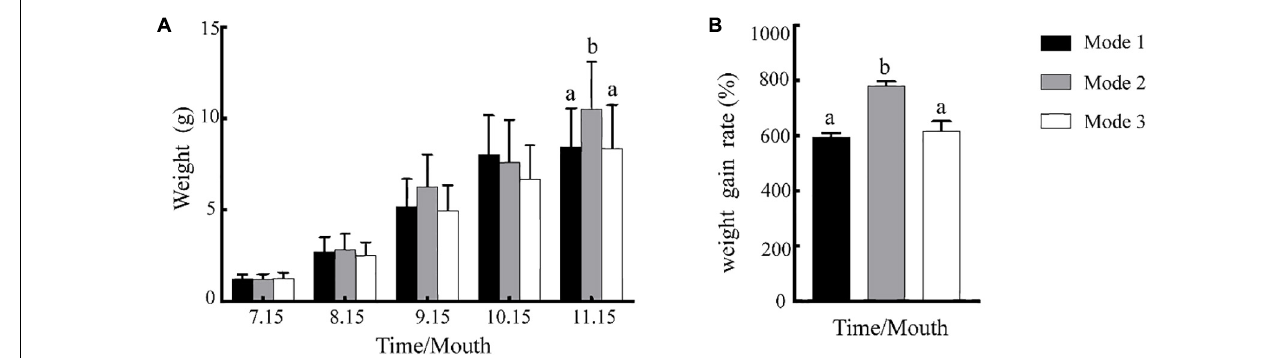
FIGURE 2 | Changes of body weight (A) and comparison of juvenile crab weight gain rates (B) during juvenile crab breeding under three feeding modes. The values on the bar graph represent the average; the error bars represent the standard deviation ( n = 40). Letters above the bars of the same series indicate significant differences between treatments ( P < 0.05). Mode 1, 2, and 3 represent traditional, formulated, and mixture feeding modes,